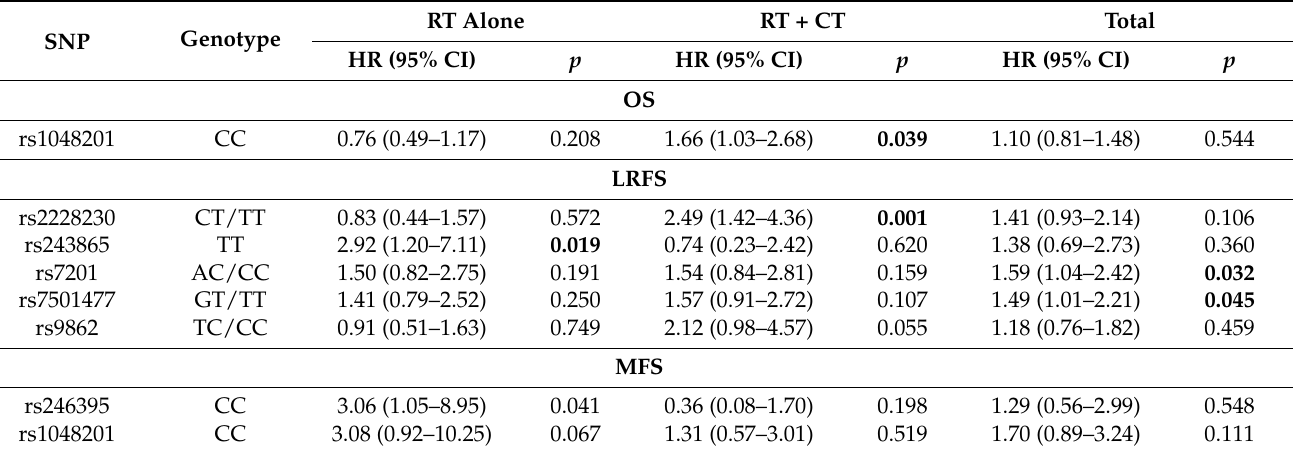
Figure 1. The Kaplan–Meier plots according to SNPs with p ≤ 0.05 in univariate analysis for: ( A , B ) locoregional recurrence-free survival (LRFS) and ( C ) metastasis-free survival (MFS) in the RT alone subgroup; ( D , E ) overall survival (OS); ( F , G ) LRFS and ( H ) MFS in the combination treatment subgroup (RT + CHT); and ( I ) LRFS in the whole group. Number of events and n are shown in the brackets. Table 1. Multivariate analysis for association of SNPs (only SNPs with p ≤ 0.100 are shown) with OS, LRFS, and